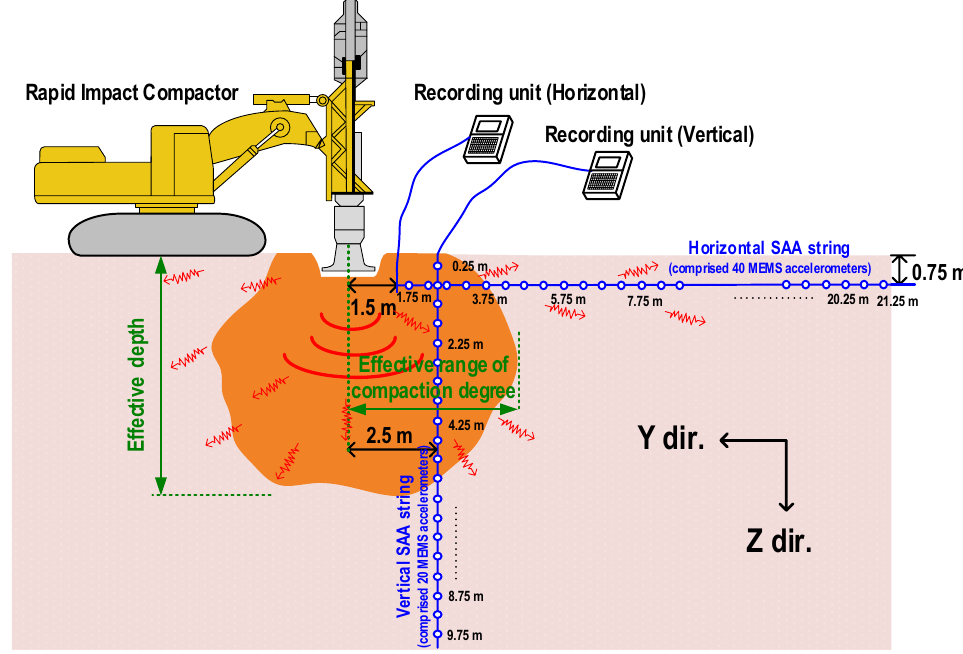
Figure 1. Proposed method for monitoring the soil acceleration caused by shear distortion during RIC compaction at various depths and propagation distances under field conditions (in Y–Z